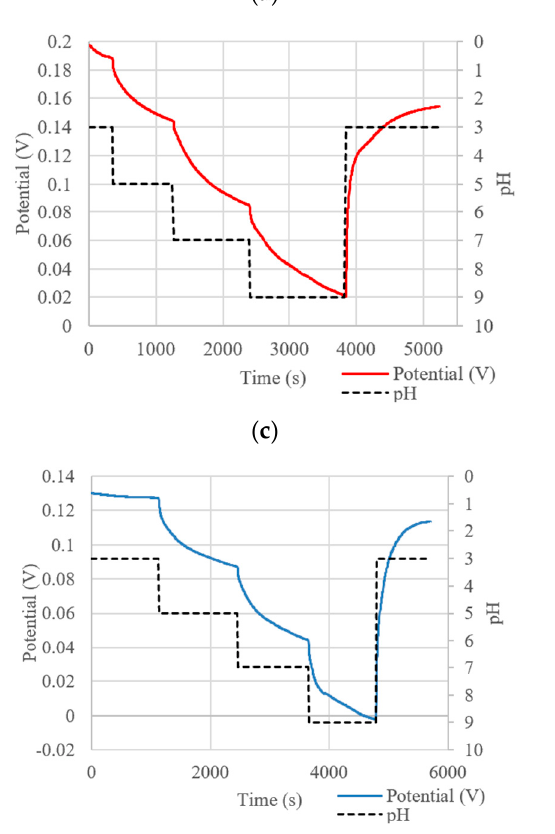
Figure 14. OCP of PANI-EB composite in ( a ) initial state, ( b ) bent state, and ( c ) unbent state along with ( d ) corresponding sensitivity curves.